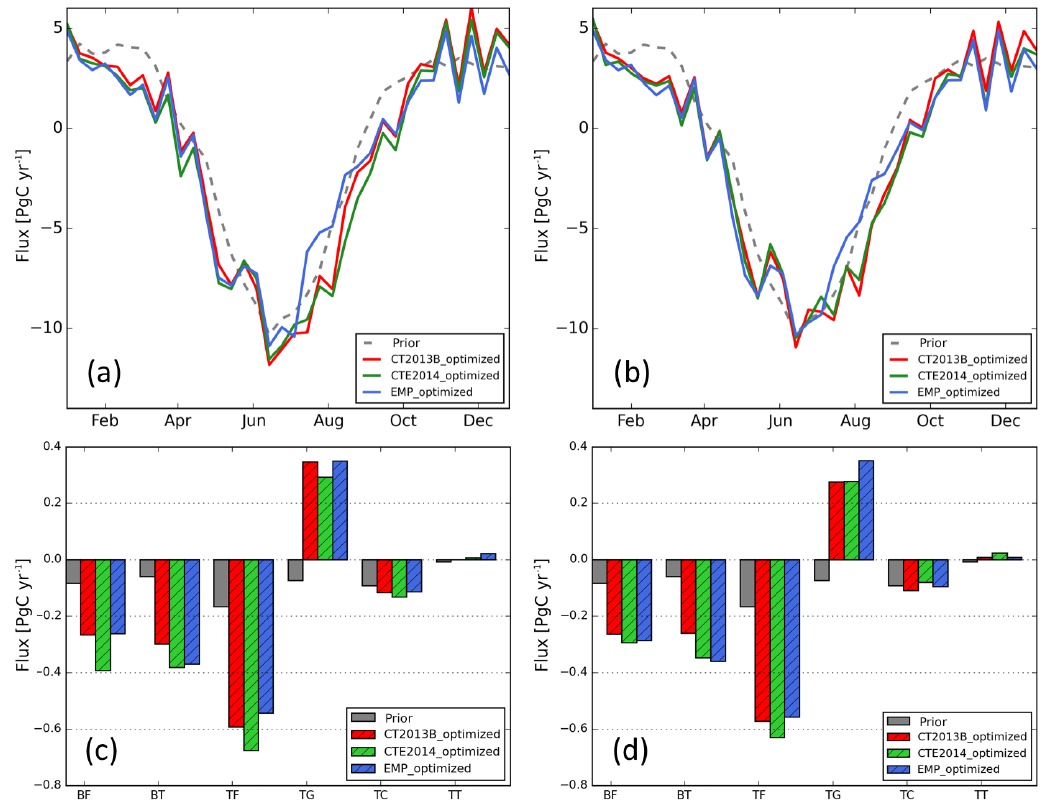
Figure 6. Mean optimized net biosphere fluxes (PgCyr − 1 ) for the runs with different prior boundary conditions (BCs): CT2013B, CTE2014, and EMP. The time series of optimized fluxes are presented for the “Flux only” inversion (a) and for the “Flux + BC” inversion (b) , respec- tively; the annual net biosphere fluxes over the aggregated Olson ecosystem types are shown for the “Flux only” inversion (c) and for the “Flux + BC” inversion (d) , respectively. Note that in panels (c) and (d) the first letters “B” and “T” of the x -axis labels are short for “Boreal” and “Temperate”, respectively; the second letters “F”, “G”, “C”, and “T” are short for ecosystem types “Forests/Wooded”, “Grass/Shrubs”, “Crops/Agriculture”, and “Tundra /Taiga”, respectively. Table 5. Optimized annual net biosphere fluxes (PgCyr − 1 ) and CO 2 boundary condition (BC) adjustments (ppm) using four prior